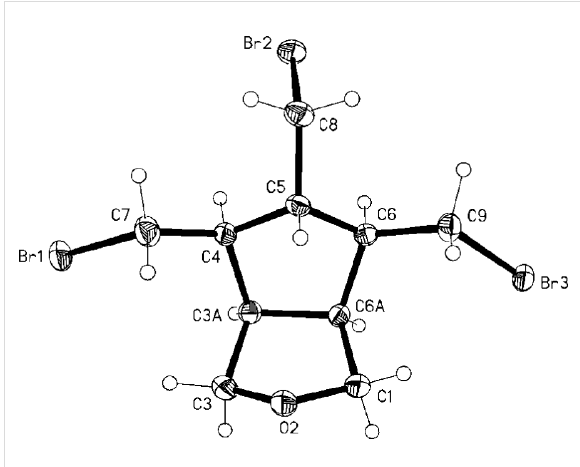
Figure 1: Structure of 19 in the crystal; ellipsoids represent 50% prob- ability levels.